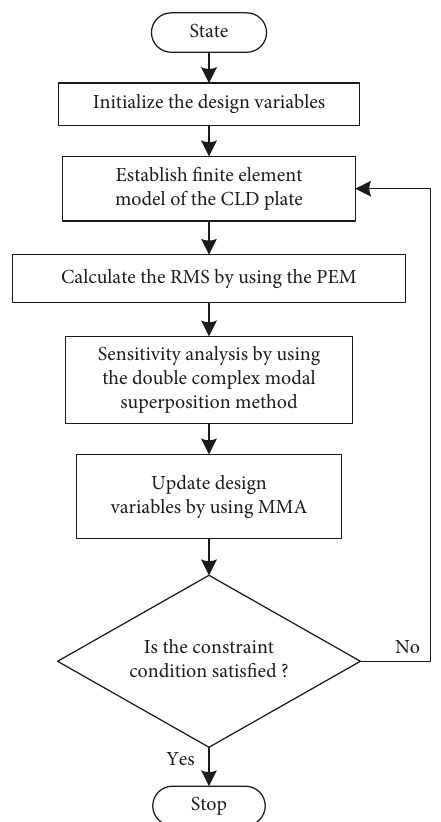
Figure 1: Block diagram of the optimization procedure.